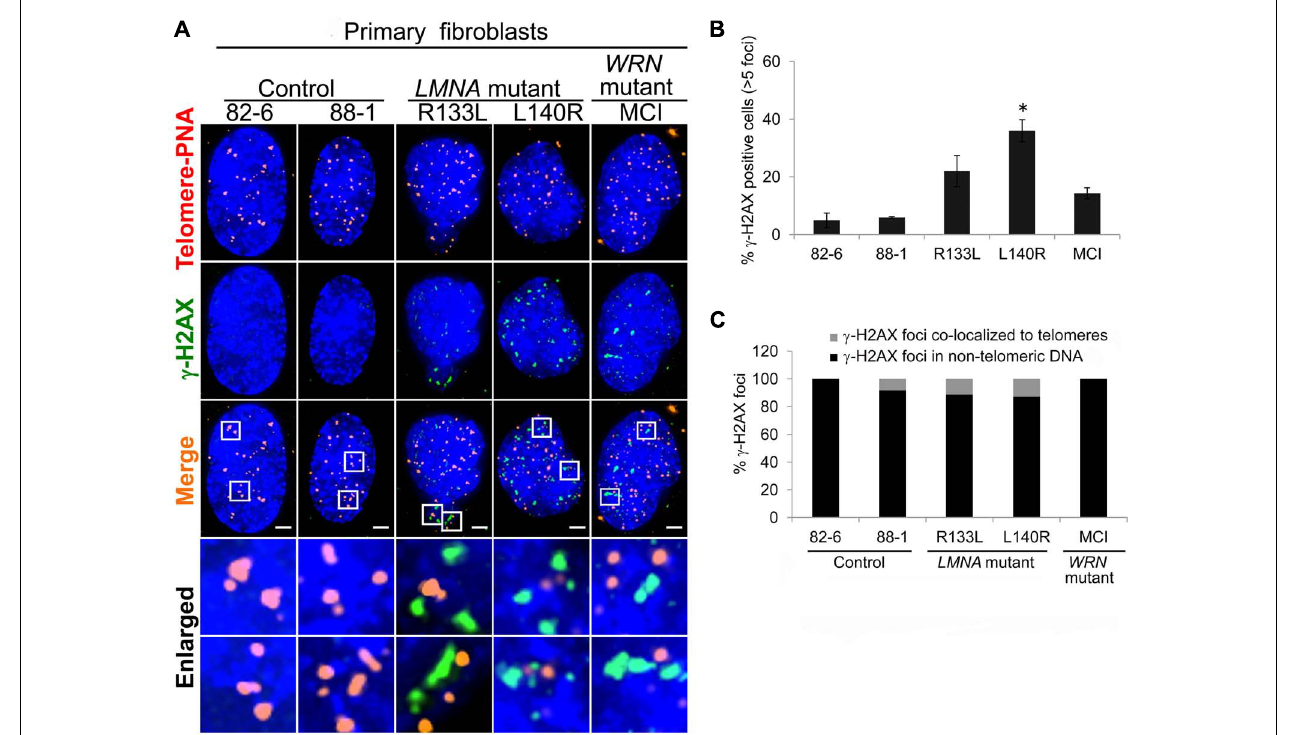
cells with > 5 γ -H2AX-labeled foci. Data are averages of three independent experiments. Bars represent ± s.d. * P < 0.05. (C) Quantitation of γ -H2AX foci detected in (A) . Signals of γ -H2AX foci overlapping telomeres (gray) and those not overlapping (black) are shown separately. A minimum of 70 cells were analyzed for each cell line. Scale bar: 2 μ